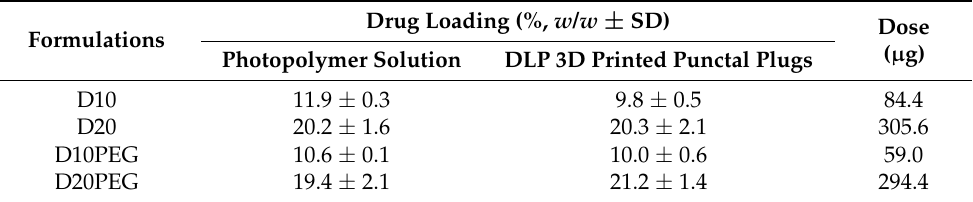
Table 3. Drug concentration in photopolymer solution and DLP 3D printed punctal plugs. Formulations